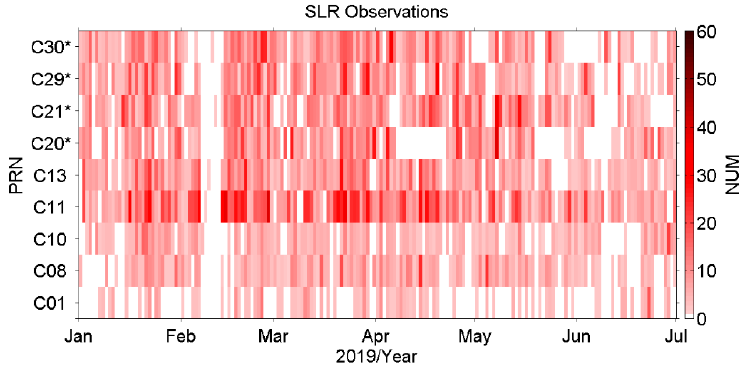
Figure 2. The daily SLR observations of BeiDou Navigation Satellite System (BDS) provided by Europe Data Centre (EDC) since 2019.